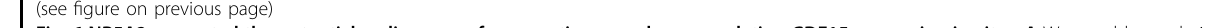
Fig. 6 NR5A2 promoted the potential malignancy of pancreatic cancer by upregulating GDF15 expression in vitro. A Western blot analysis and RT-qPCR to show the GDF15 expression in AsPC-1 and HPAC cells infected with pcDNA3.1 or GDF15 plasmid. GAPDH served as an internal reference. Data presented as the mean ± SD of three independent experiments, *** p < 0.001, one-way ANOVA. B – F AsPC-1 and HPAC cells infected with pcDNA3.1 or GDF15 plasmid were harvested for MTS assay (B, n = 5), colony formation assay ( C , D ), and transwell invasion assay ( E , F ). Each bar represents the mean ± SD of three independent experiments. *** p < 0.001, one-way ANOVA. G Western blot analysis and RT-qPCR to show the GDF15 expression in AsPC-1 and HPAC cells infected with shControl or shGDF15. GAPDH served as an internal reference. Data presented as the mean ± SD of three independent experiments, *** p < 0.001, unpaired t test. H – J AsPC-1 and HPAC cells infected with shControl or shGDF15 were harvested for MTS assay ( H , n = 5), colony formation assay ( I ), and transwell invasion assay ( J ), scale bars: 100 μ m. Each bar represents the mean ± SD of three independent experiments. *** p < 0.001, unpaired t test. K – M AsPC-1 cells infected with pcDNA3.1, NR5A2, or NR5A2 + shGDF15 were harvested for colony formation assay ( K ), MTS assay ( L , n = 5), Invasion assay ( M ) and wound healing assay ( N ), scale bars: 100 μ m. Each bar represents